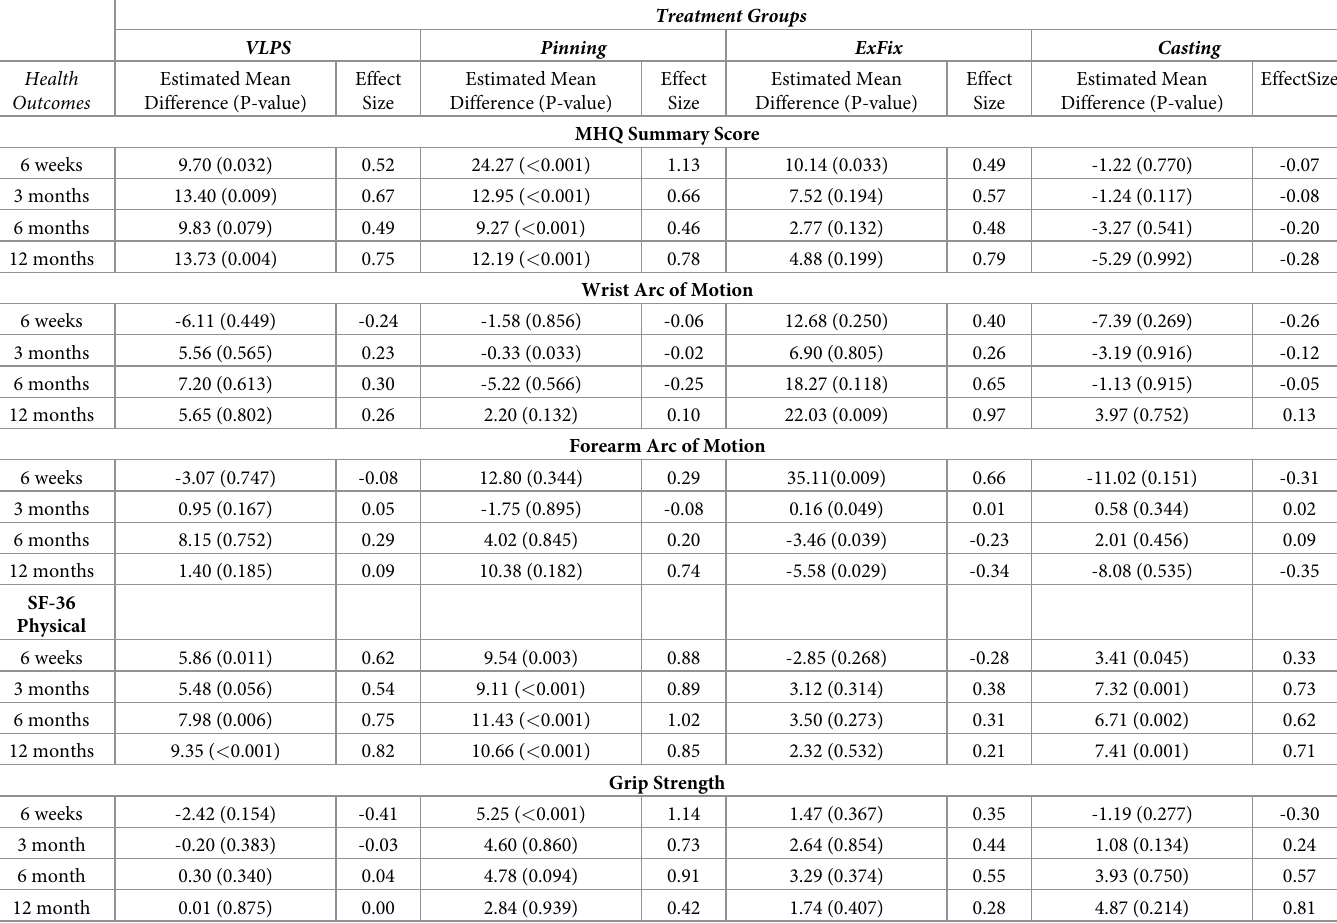
Table 4. Generalized estimating equation model results comparing highly and less-active participants based on treatment. The estimated mean differences and p-val- ues are for β 1 (6 weeks), β 1 + β 2 (3 months), β 1 + β 3 (6 months) and β 1 + β 4 (12 months),